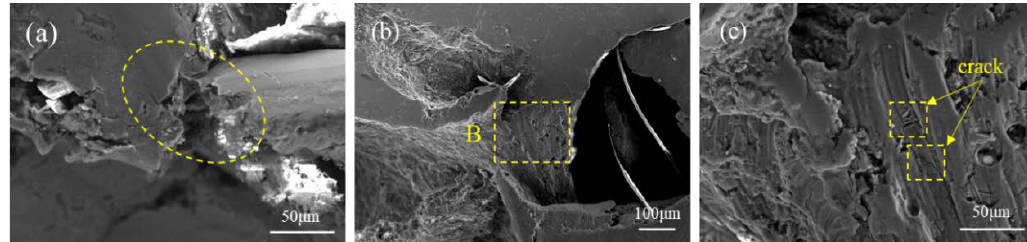
Figure 8. Failure morphology of BF-containing aluminum foam: ( a ) BF breaking simultaneously with